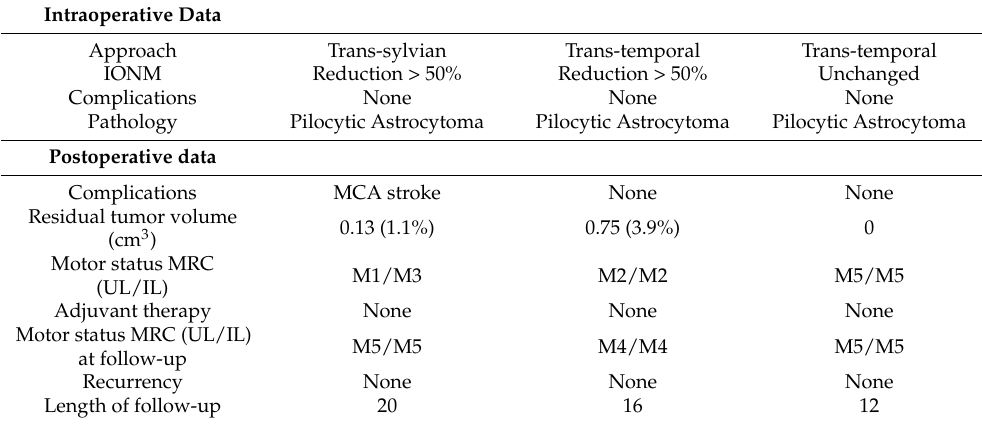
Table 3. Intraoperative and postoperative